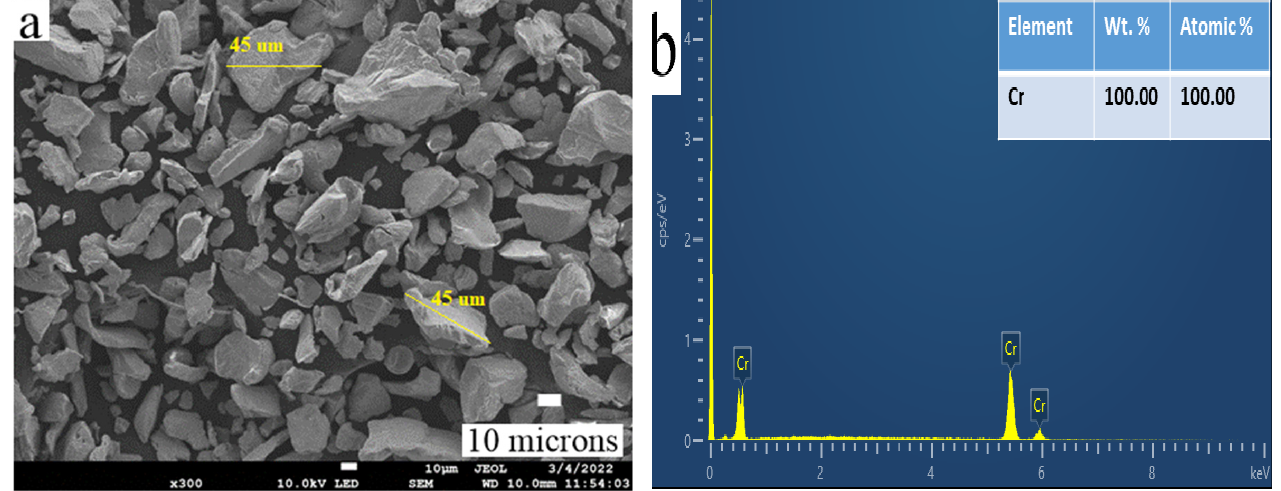
Figure 4. ( a ) FE-SEM image of Cr powder and ( b ) EDS image of Cr powder. Optical microscopy images of the as-cast NAB and the FSPed composite are shown in